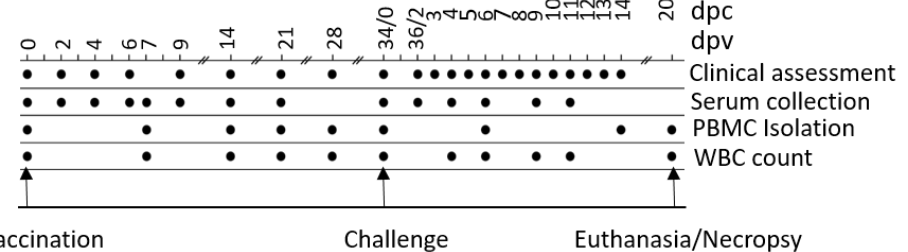
Figure 3. Vaccination, sample collection, challenge, and euthanasia scheme for the animal experiment. dpc: days post challenge; dpv: days post vaccination; PBMC: peripheral blood mononuclear cells; WBC: white blood cells